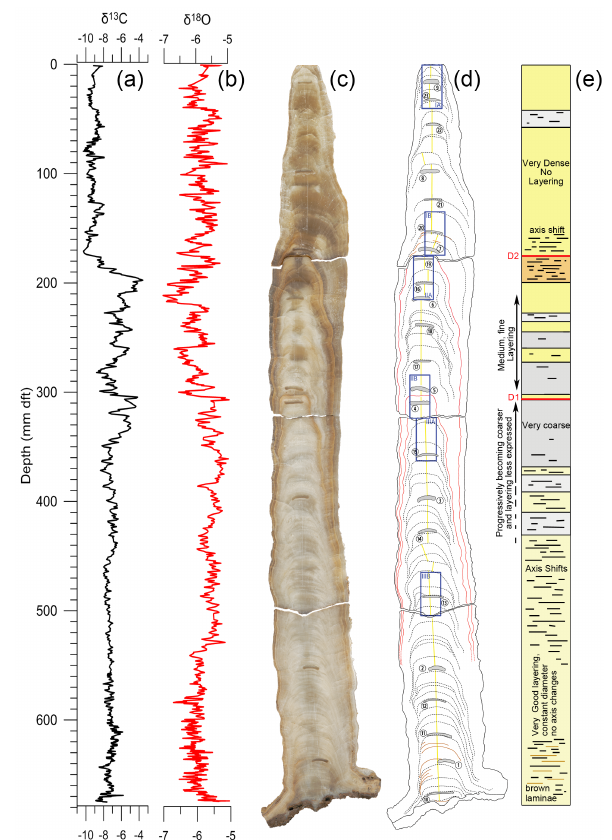
Figure 2. Descriptive image of Han-9 (a) δ 13 C plotted against dis- tance from top in mm; (b) δ 18 O plotted against distance from top in mm; (c) high-resolution scan of the polished slabs; (d) interpre- tation of the internal structure of the speleothem. Dashed lines: dis- tinctive layers; red lines: growth discontinuities; grey areas: dating samples, where numbers refer to the samples in Table 1; yellow line: central axis (sample axis); blue boxes: thin section locations; brown lines: detrital material. (e) Stratigraphic log: colors indicate the presence of dense calcite (yellow) or coarse calcite (grey); more intense color: denser/coarser compared to lighter colored parts. The visual expression of layering is indicated with the dashes in the log. Further description of the log can be found in the figure and